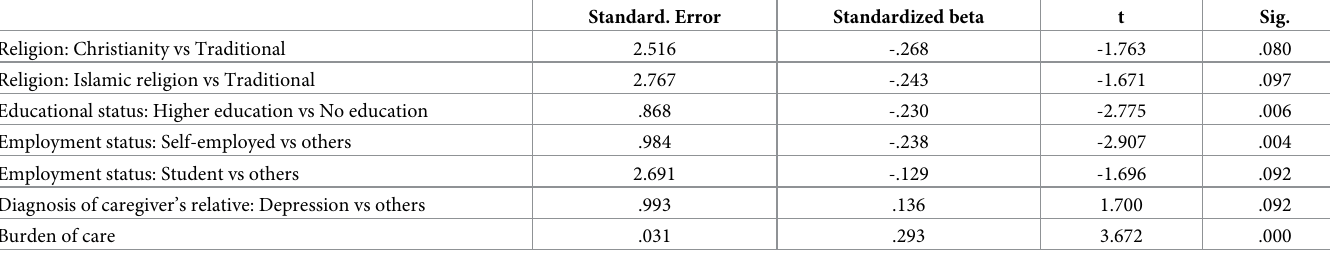
Table 3. Linear regression for the predictors of psychological distress during care of mentally ill. Standard. Error Standardized beta t